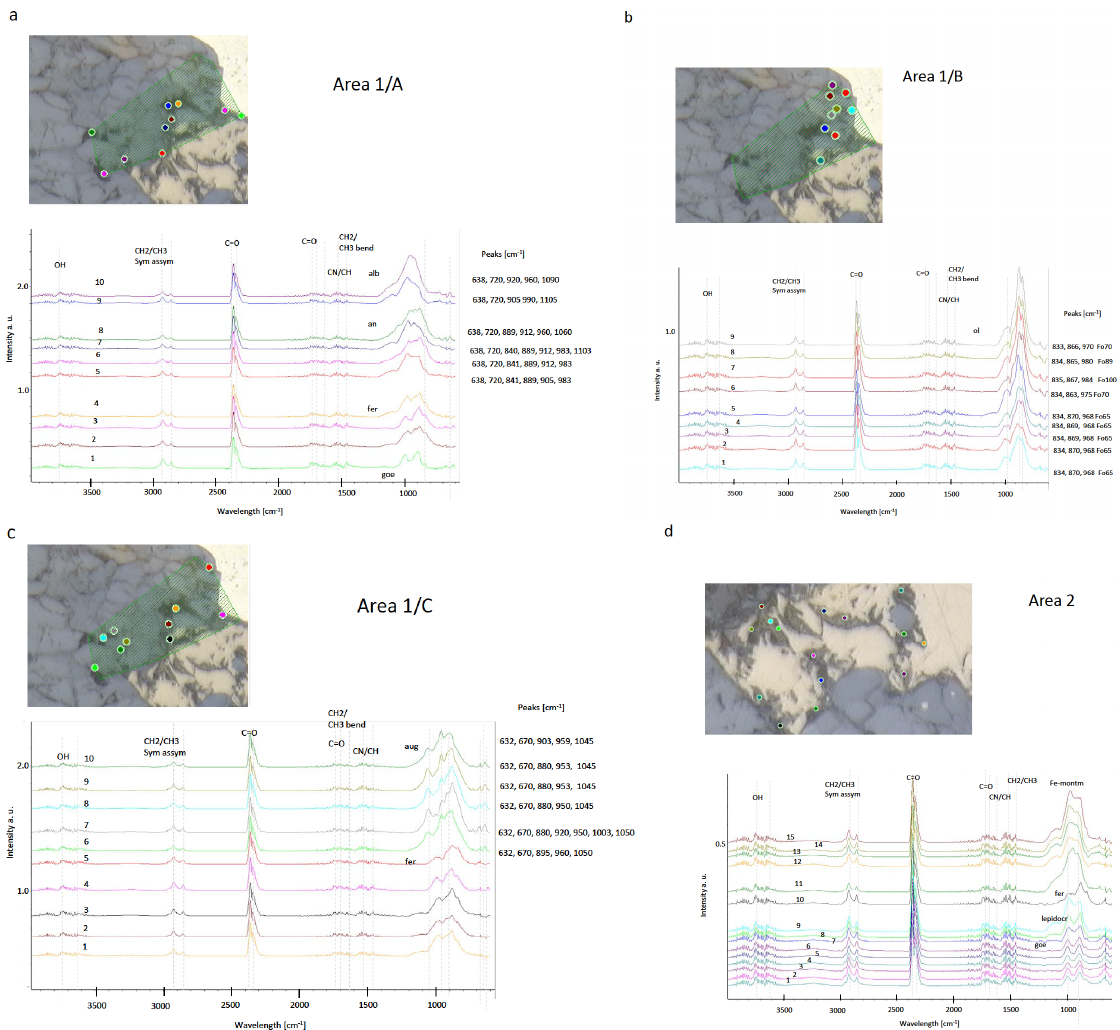
Figure 4. ATR-FTIR spectroscopy results of Mócs meteorite. Measuring Area 1 (a, b, c) is around bio-degraded area of opaque (troilite) grains (light phase), which are surrounded by olivine (spectrum groups A, B, C). The measuring points of iron-oxidizing bacterial structures have a mixed composition containing iron oxides (ferrihydrite and goethite), olivine, montmorillonite and hydrocarbon peaks (long chain hydrocarbon, C-H stretching of aliphatic hydrocarbons, etc.); Area 2 (d) represents opaque (troilite) phase, which contain montmorillonite, iron oxides and hydrocarbons. The IR vibrations of isoprenoids were also detected. Abbr: (a) alb-albite, an-anortite, fer-ferrihydrite, goe- goethite; (b) ol-olivine; (c) aug-augite, fer-ferrihydrite; (d) Fe-montm-Fe-montmorillonite, fer-ferrihydrite, lepidocr-lepidocrocite, goe-